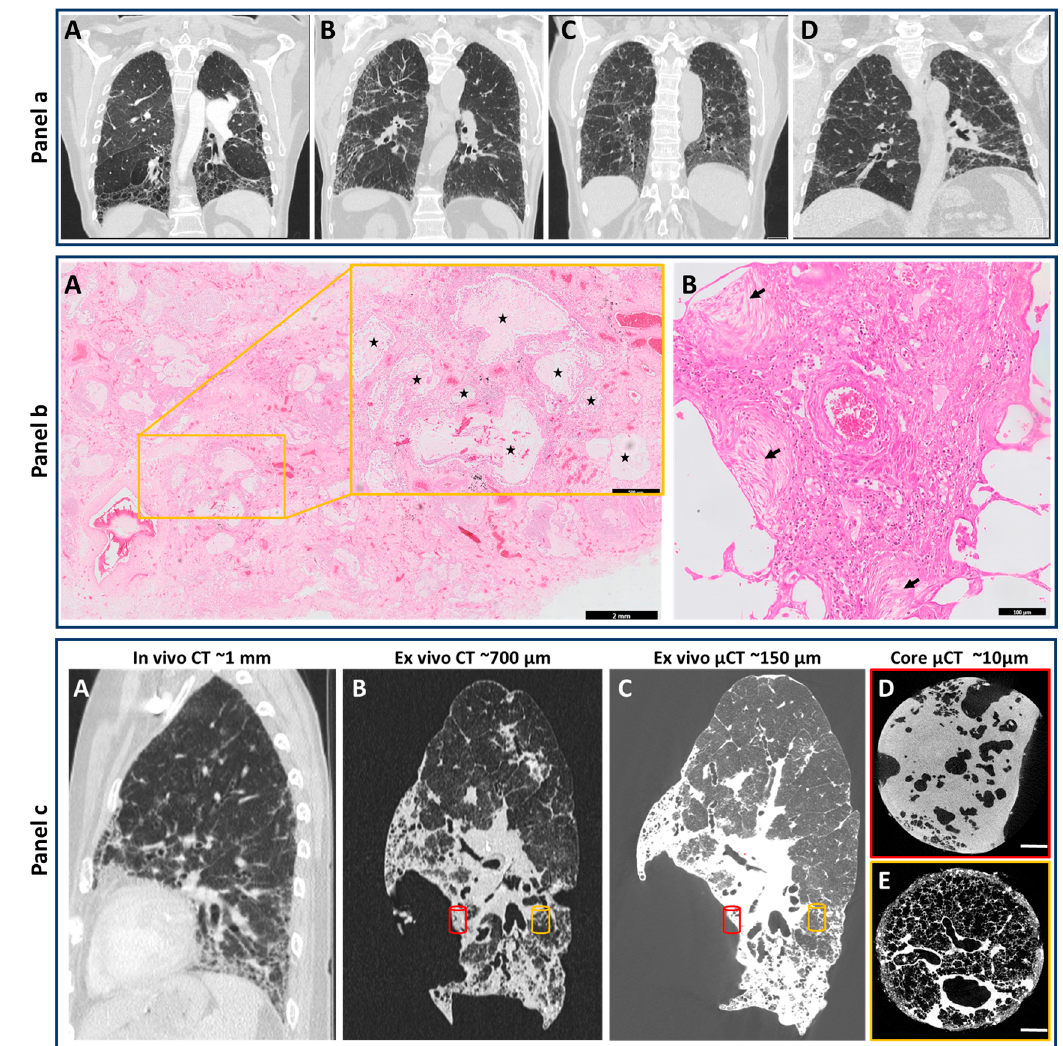
Figure 1. HRCT and Histopathological features for diagnosis of human UIP pattern, and overview of the potential use of CT and μ CT for understanding the clinical pathology of end-stage IPF. Panel ( a ), HRCT: ( A ) Typical UIP in the setting of IPF. The presence of a peripheral, subpleural predominantly basal irregular reticular pattern, basal honeycombing and peripheral traction bronchiectasis makes IPF very likely; ( B ) Probable UIP in the setting of IPF. Peripheral and subpleural irregular reticular pattern with distal traction bronchiectasis but without honeycombing makes IPF very likely in case also clinical findings suggest this diagnosis; ( C ) Nonspecific interstitial pneumonia (NSIP). The dominant presence of ground-glass opacity together with a fine regular reticular pattern and proximal traction bronchiectasis makes IPF less likely; ( D ) Chronic fibrotic hypersensitivity pneumonitis. Irregular lines and reticular pattern are present throughout both lungs without peripheral dominance. In addition, lung density is inhomogeneous. IPF is unlikely and clinical arguments for an alternative diagnosis should be looked for. Panel ( b ): Histopathology of human lung (HE-staining). ( A ) Presence of honeycombing (inset, enlarged from yellow box, black stars) by formation of cystic airspaces of varying sizes filled with mucus and lined by bronchiolar epithelium (A scale bar = 2 mm, scale bar in inset = 500 μ m); (B) Fibroblast foci showing interstitial ongoing fibrosis without inflammatory infiltrates are indicated by black arrows (scale bar = 100 μ m). Panel ( c ): In vivo chest HRCT scan 6 months prior to transplantation with a resolution of around 1 mm ( A ); Ex vivo CT of the transplanted lung highlighting an increased spatial resolution due to the absence of breathing artefacts ( B ); Whole lung ex vivo μ CT showing sagittal view with a resolution up to 150 μ m ( C ); Core μ CT with a resolution of 10 μ m provides insight into different areas within the lower lobe showing severe fibrosis (red cylinder) and a near-normal area (orange cylinder) demonstrating the need for rigorous characterization of separate regions within the same lung specimen ( D , E ).